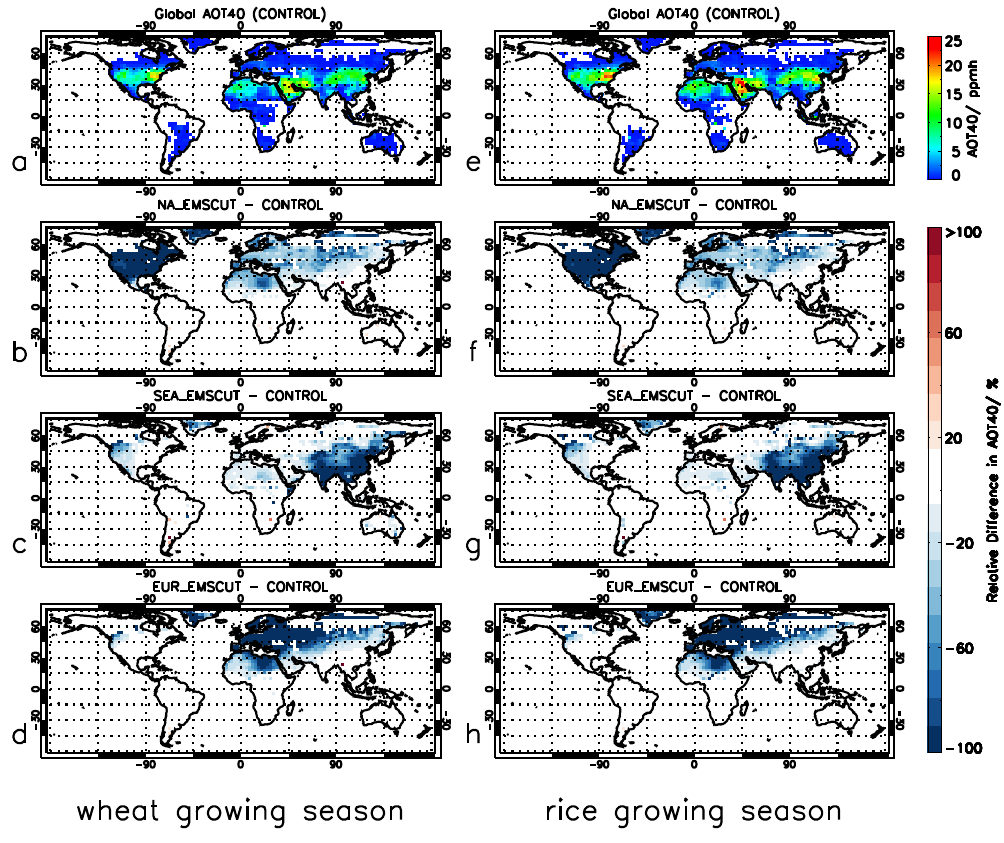
Fig. 7. (a) Global AOT40 under the control model scenario for the wheat growing season; and relative difference in AOT40 between the control model and 100% cut in anthropogenic NO x emissions from (b) N America, (c) SE Asia, and (d) Europe for the same period. Panels (e–h) show the same but for the rice growing